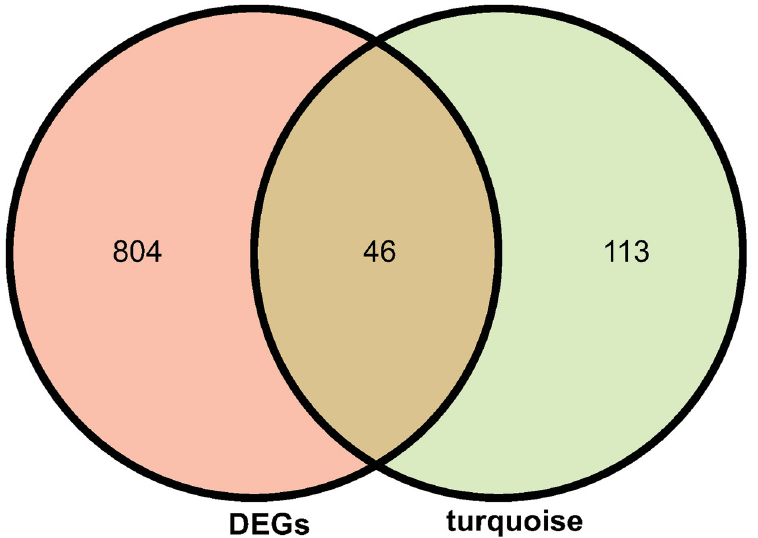
Fig 4. The intersection of DEGs in the GSE150392 dataset and turquoise module genes in the GSE167028. There were 850 DEGs in the GSE150392 dataset and 159 genes in the turquoise module of the GSE167028 dataset, and 150 genes were obtained as common genes by overlapping the two